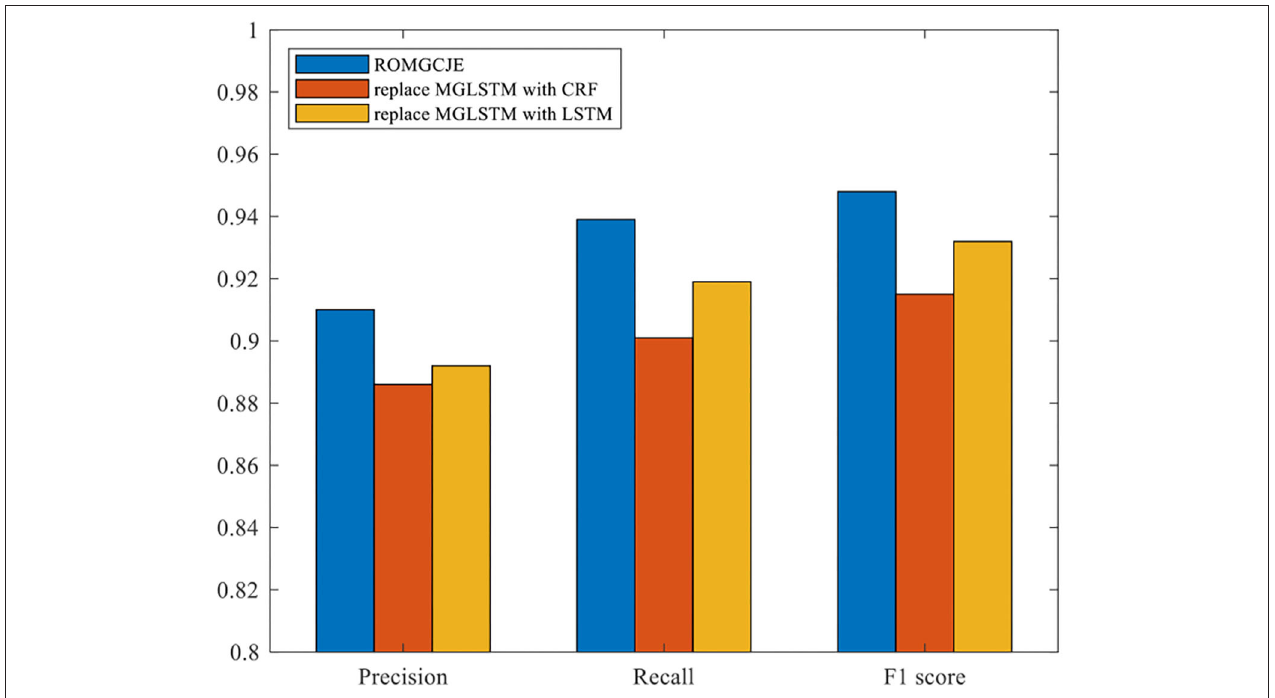
FIGURE 8 | Ablation experiments for MGLSTM on the NYT dataset.